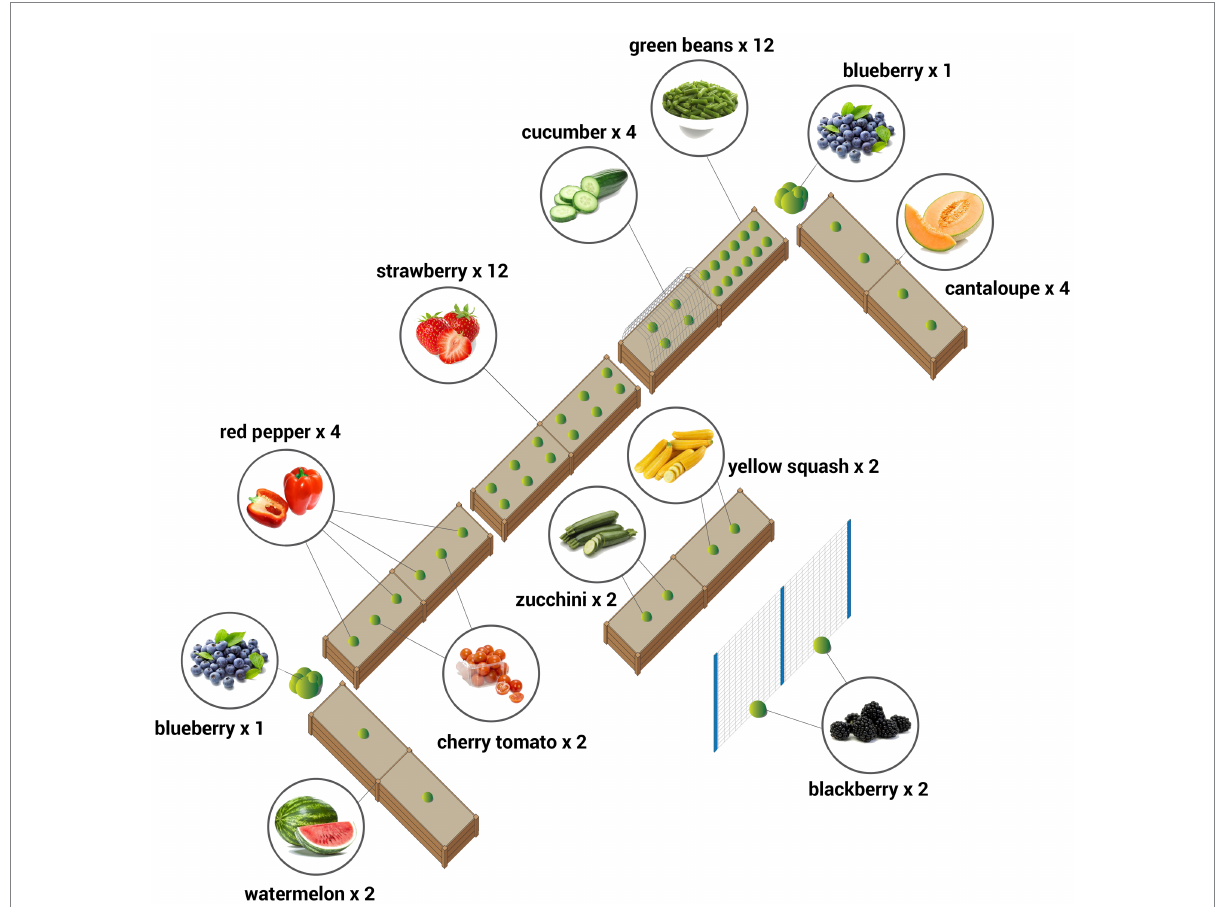
FIGURE 1 Standard garden layout (re-configured on-site to conform to spatial constraints as